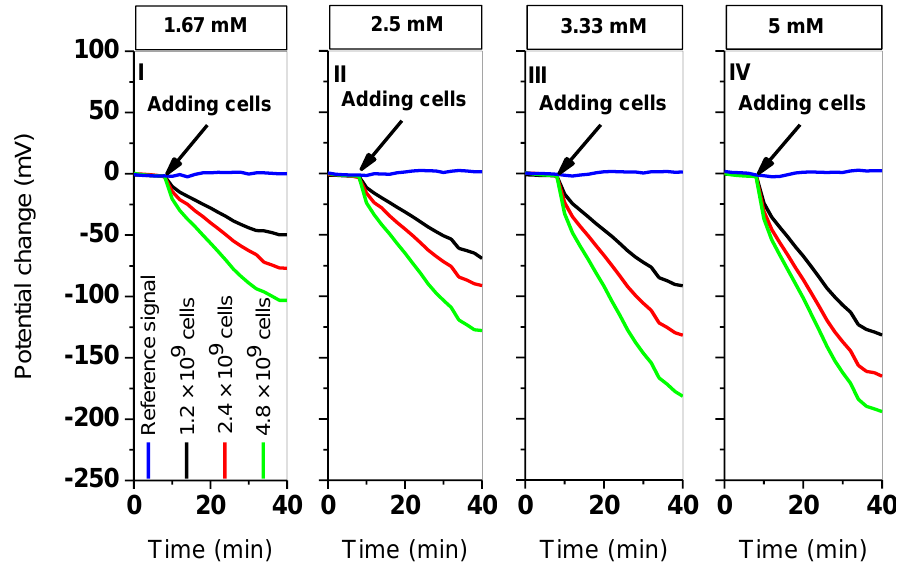
Figure 2. Four-chamber differential LAPS measurement with varying cell number of L. brevis (1.2 × 10 9 , 2.4 × 10 9 , 4.8 × 10 9 cells in 200 µL cell suspension) and varying glucose concentration (1.67, 2.5, 3.33, 5 mM). Potential changes of four successive independent measurements with an ascending series of glucose concentrations. Blue line: reference sensor signal without cells; black, red, and green lines: active sensor sites with cells. Four laser-diode modules (LDMs) were considered for each chamber (each curve corresponds to calculated mean values).